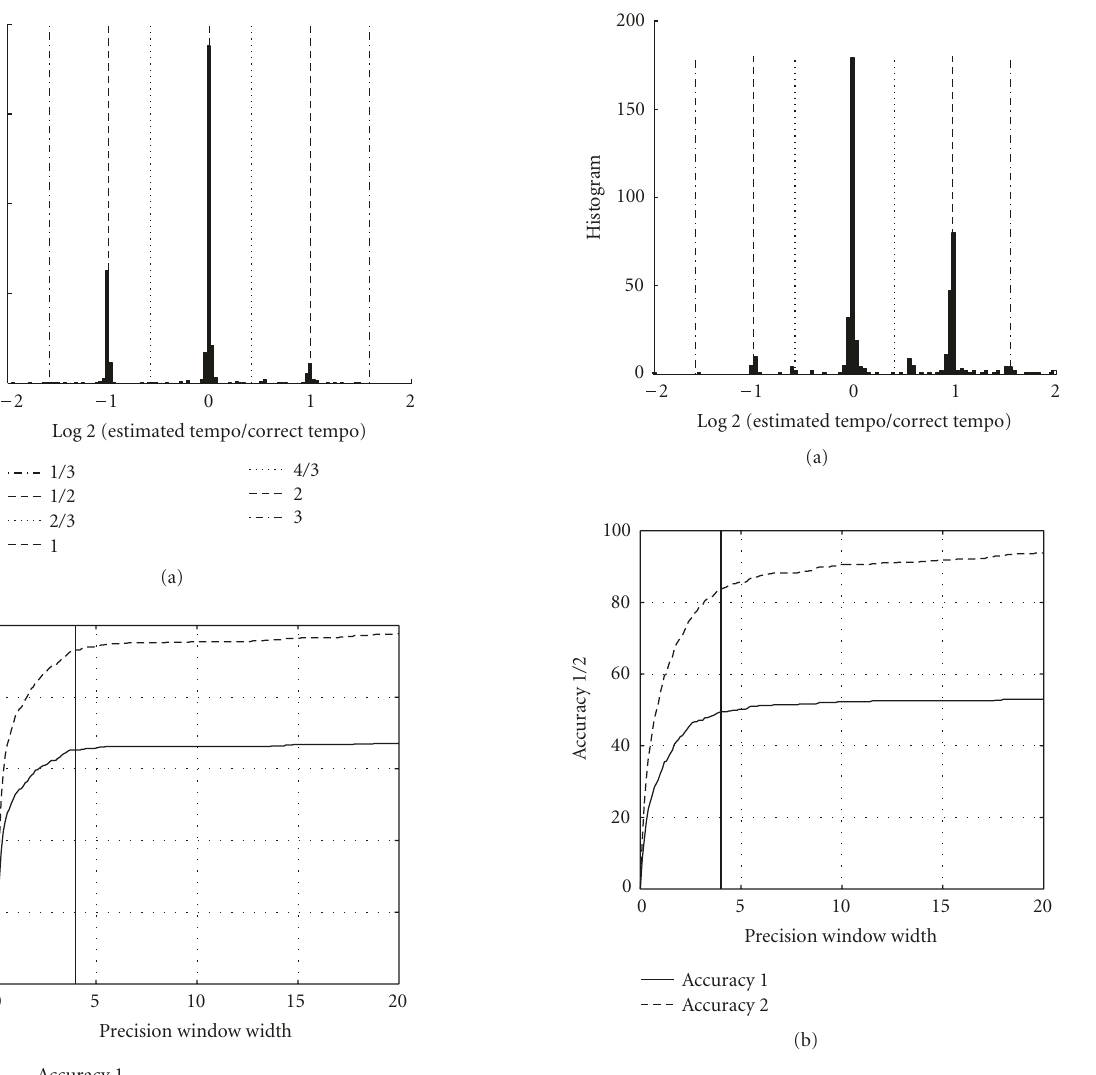
Figure 11: Same as Figure 10 for the songs